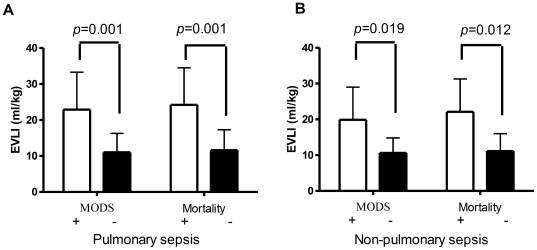
Extravascular lung water index (EVLWI).EVLWI in patients with and without multi-organ dysfunction syndrome (MODS), and mortality in pulmonary sepsis (A) and in non-pulmonary sepsis patients (B), Open bars, patients with MODS or mortality; filled bars, patients without MODS or mortality. p value was expressed.